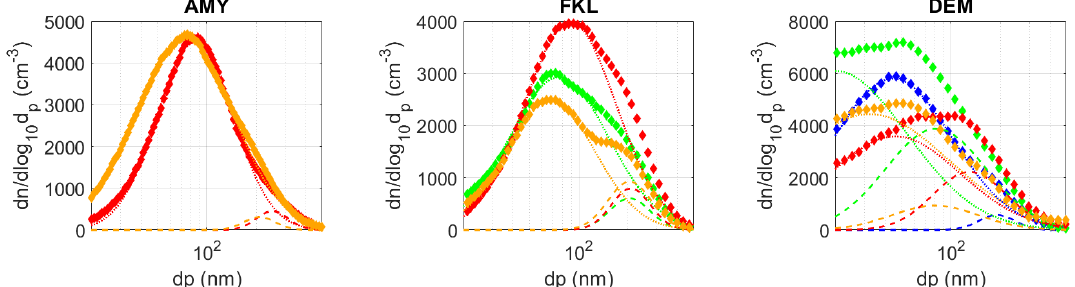
Figure A3. Median particle size distributions (diamonds) and corresponding modes (dotted lines) at coastal sites. See Fig. A1 for an expla- nation of the symbols.